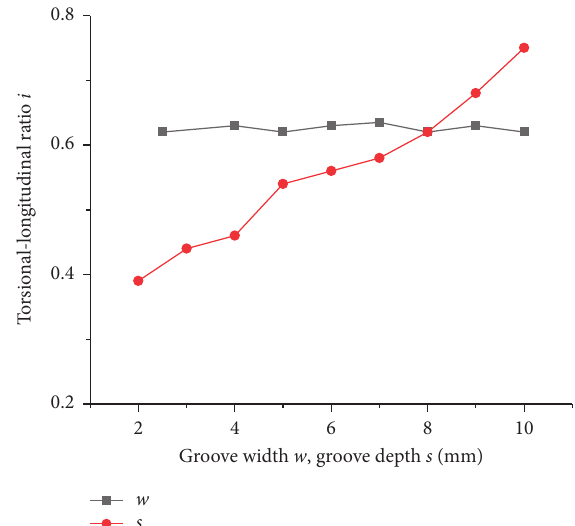
Figure 14: The effect of groove width w and groove depth s on torsional-longitudinal ratio i